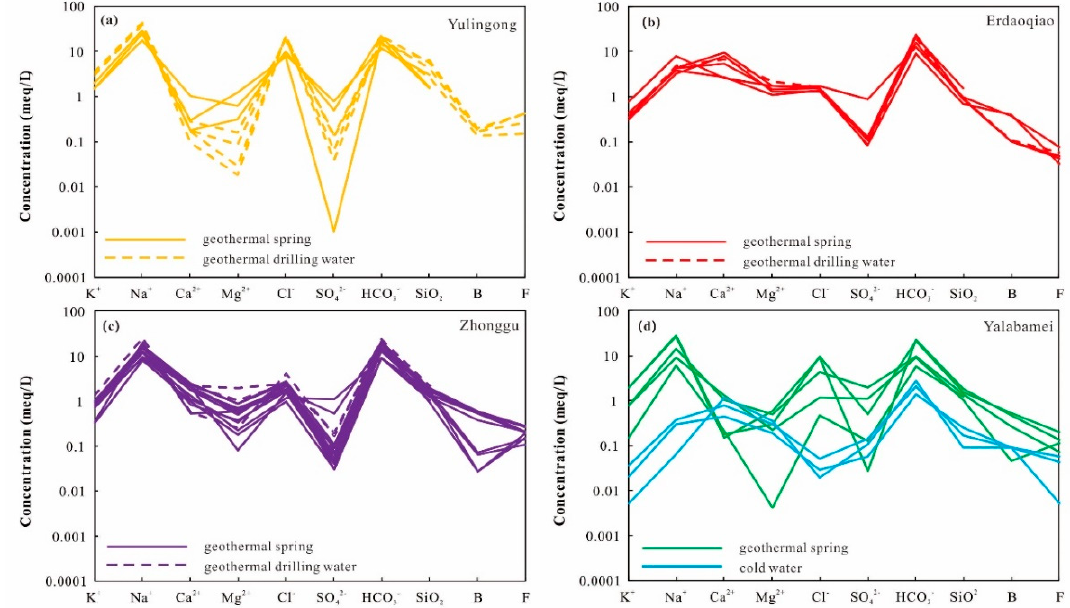
Figure 2. Schoeller semilogarithmic diagram of geothermal water samples from the ( a ) Yulingong area, ( b ) Erdaoqiao area, ( c ) Zhonggu area, and ( d ) Yalabamei area, with cold water samples here instead of geothermal drilling water.